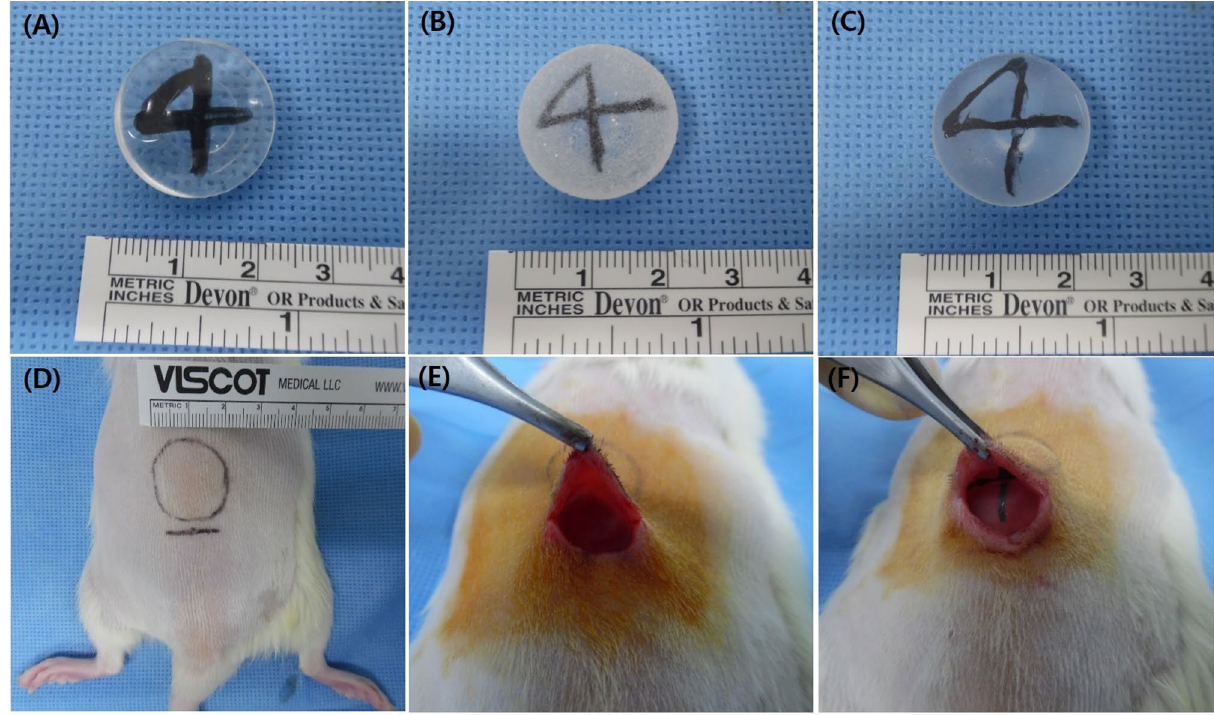
Figure 7. Three types of implants and surgical implantation procedure. ( A ) Smooth, ( B ) macrotexture, and ( C ) nanotexture types: Three types of implants with different topographies that have a directional marker made of tantalum specially manufactured by Hans Daeduk Engineering Research Lab (Daejeon, Korea), a hemispherical shape, a diameter of 2 cm, and a volume of 2 cm 3 . ( D ) The design was made on the back area of Wister rats, while the incision line was approximately 2 cm at the place where the implant is expected to be located. ( E ) Dissection with metzenbaum was done under the panniculus carnosus muscle. ( F ) The implant was placed under the panniculus carnosus